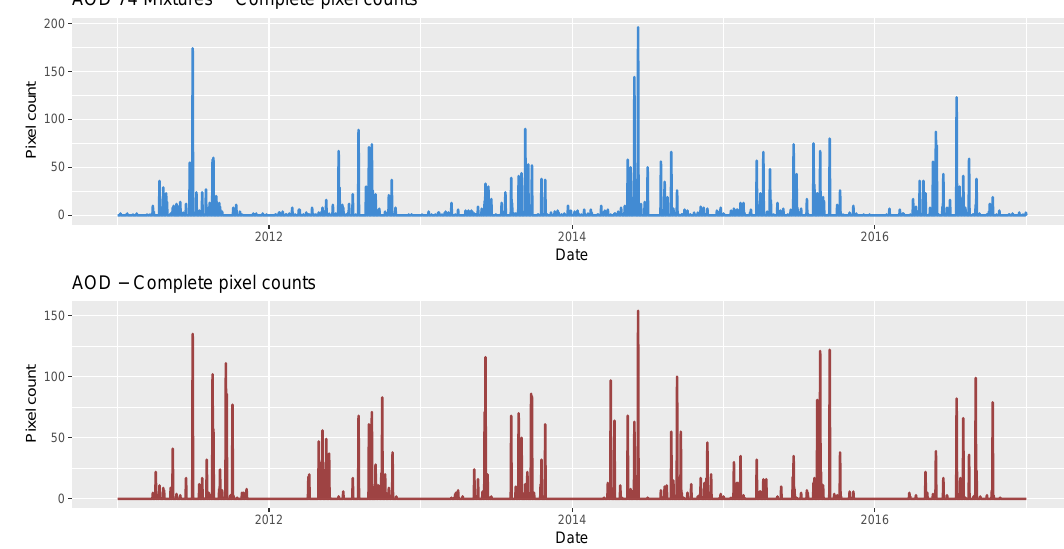
Figure A2. Frequencies of successful MISR 74 AOD mixtures and AOD over the study period